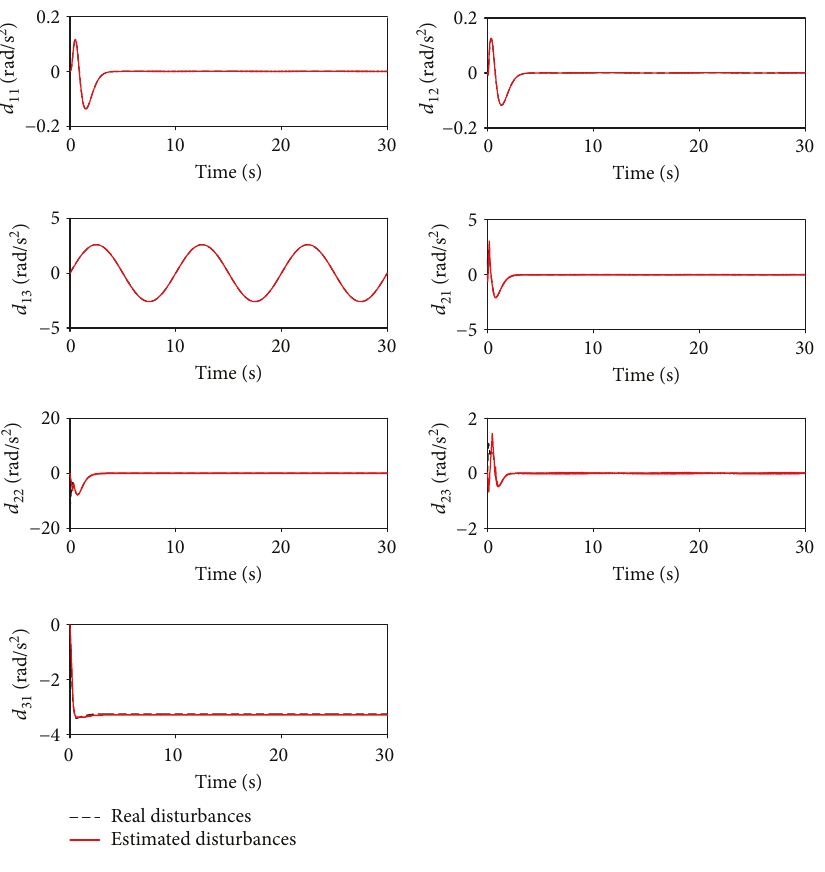
Figure 3: Disturbance estimation of